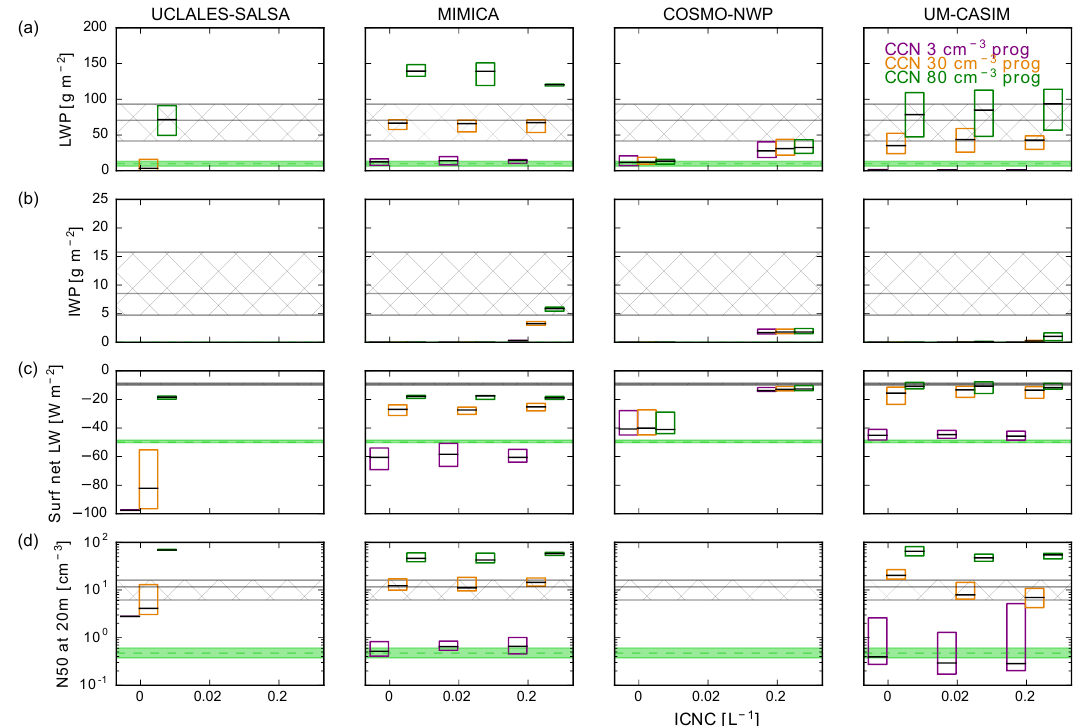
Figure 15. Cloud and surface properties for all simulations with prognostic aerosol. (a) Liquid water path, (b) ice water path, (c) surface net longwave radiation, and (d) N50 concentrations at 20m from the surface. Each subplot shows results from a single model. From left to right: UCLALES-SALSA, MIMICA, COSMO-NWP, and UM-CASIM. Simulations with an initial CCN concentration of 3 (CCN03prog), 30 (CCN30prog), and 80cm − 3 (CCN80prog) are shown as purple, orange, and green boxes, respectively. Within each subplot, the ICNC is increased from left to right as 0, 0.02, and 0.2L − 1 . Boxes show the interquartile range over model results after 31 August 12:00UTC, and the black horizontal lines denote the medians. Hatched regions indicate the observed interquartile range for the cloudy period, and the green shaded regions indicate the range for the nearly cloud-free period. Note that N50 concentrations are not available from the COSMO-NWP